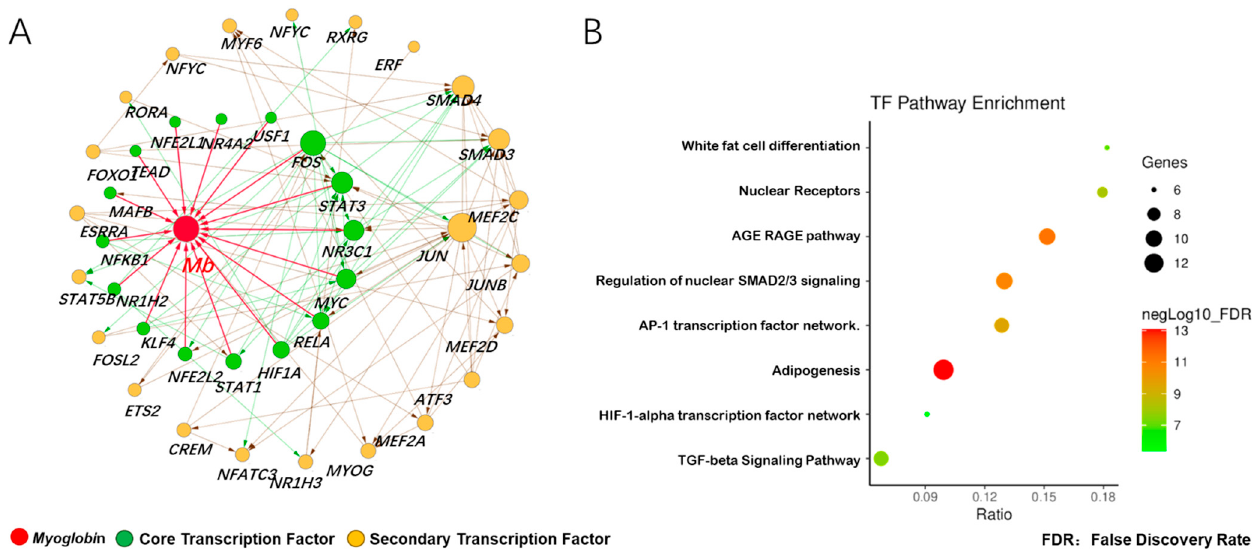
Figure 3. Prediction of adaptive transcription factors of porcine Mb gene and construction of its interaction network. ( A ) transcription factor interaction network of the porcine Mb gene. The network is constructed using the interaction data from the STRING database via the Cytoscape software. Red, myoglobin; green, core transcription factor; orange, secondary transcription factor. The size of the node (protein) indicates node connection degree (interaction relationships); ( B ) pathway enrichment of transcription factors of the porcine Mb gene.